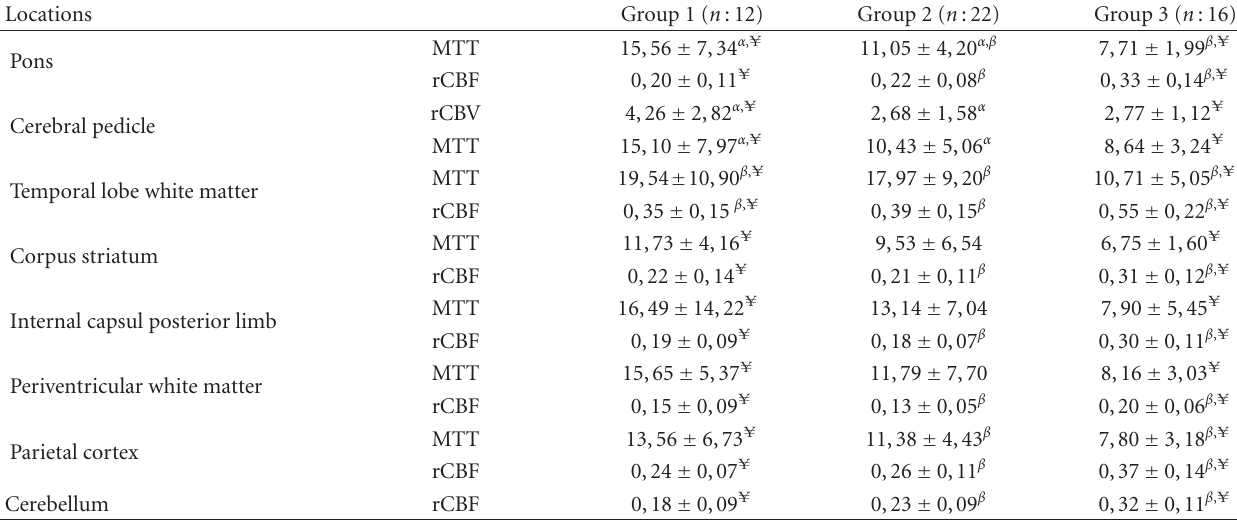
Table 2: Statistically significant di ff erences in perfusion parameters are